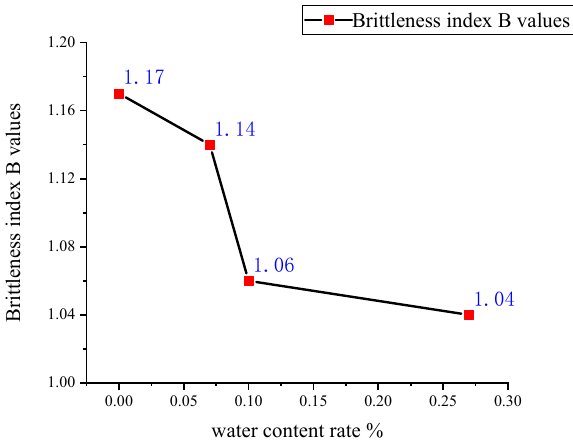
Figure 7. Brittleness index B values of limestone samples with different water content Figure 7. Bri tt leness index B values of limestone samples with di ff erent water content rates. 5. Analysis of Energy and Bri tt leness of Plasticity under Uniaxial Compression M. Aubertin de fi nes the ratio (𝑈 (cid:3031) /𝑈 (cid:3032) ) of the dissipated strain energy to the releasa-